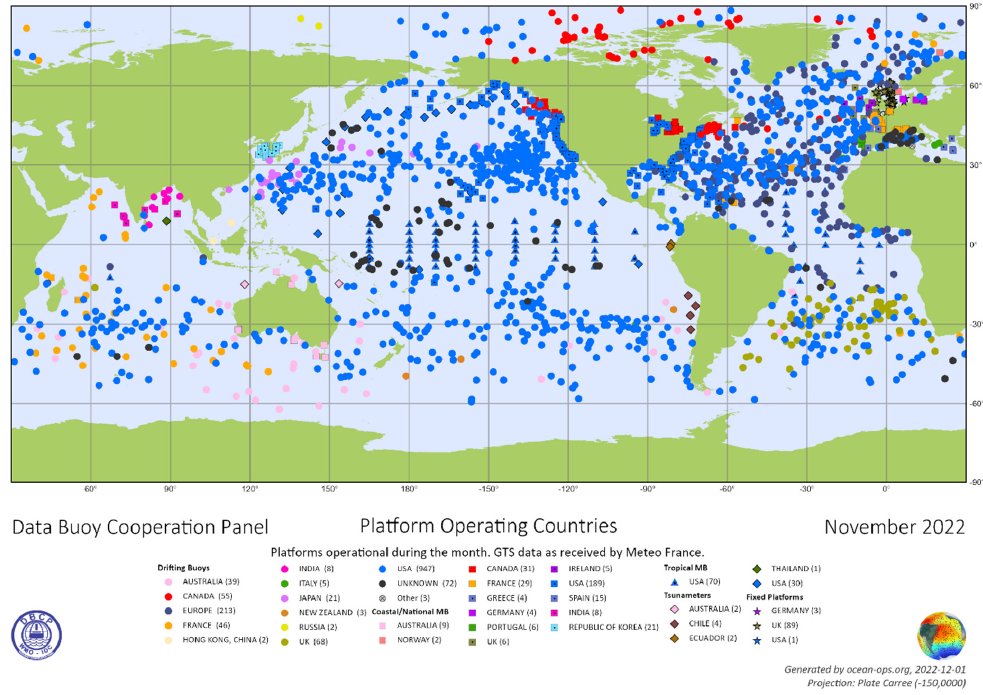
Figure 29. Locations of fixed buoys operated through the Data Buoy Cooperation Panel.